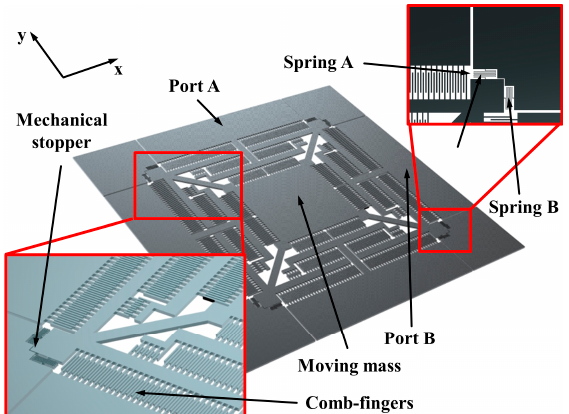
Figure 1. Schematic view of the electrostatic multi-mode energy harvester fabricated using a silicon-on-insulator (SOI) process.